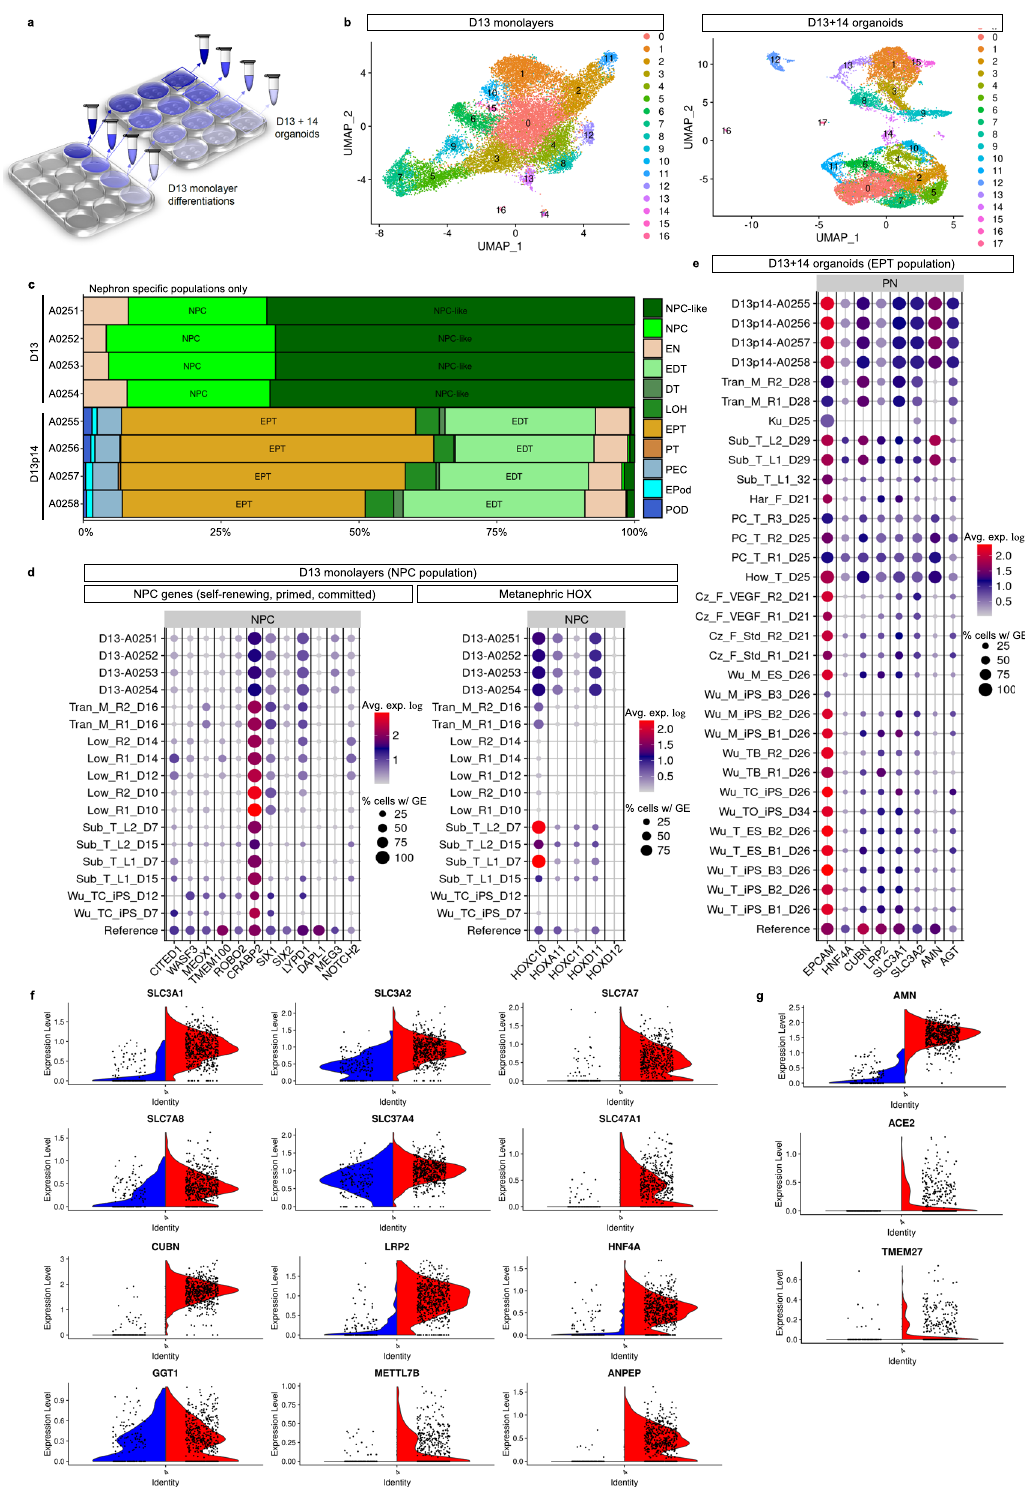
0.9% stromal cells (Supplementary Fig. 3A), analysis of the D13 sam- ple following DevKidCC classi fi cation con fi rmed a lack of stromal progenitor (SP) and medullary stroma (MS) zone markers, while expression of cortical stroma (CS) and pre-cartilage markers were limited (Fig. 5a, top left plot). This suggested that these de fi niti- ve CS and pre-cartilage populations arise during the organoid culture period, but possibly from precursor NPC-like and/or unclassi- fi ed cell populations in the D13 monolayer owing to their dominance